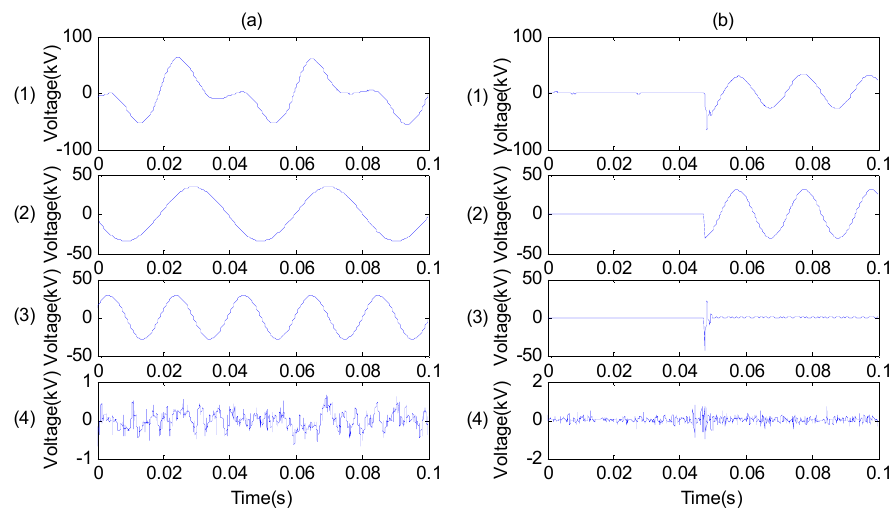
Figure 9. ( a ) Decomposition of sub-frequency ferroresonance; ( b ) Decomposition of single phase grounding mixed with arc grounding